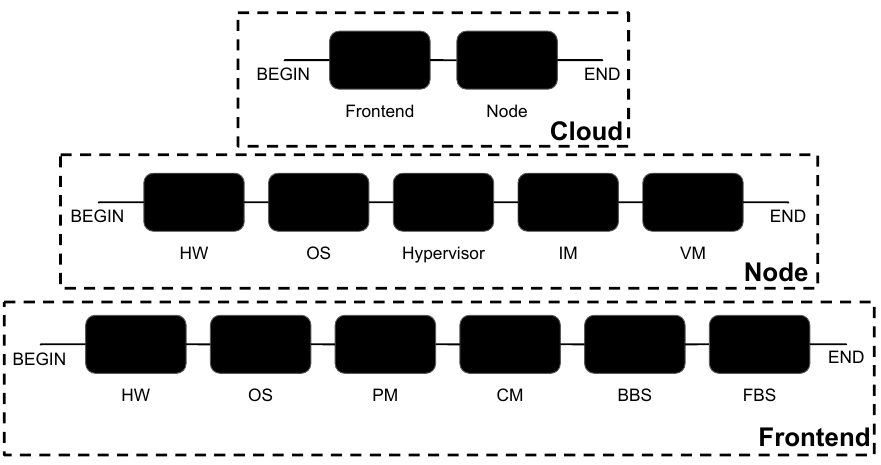
Figure 6. RBD model for the cloud.